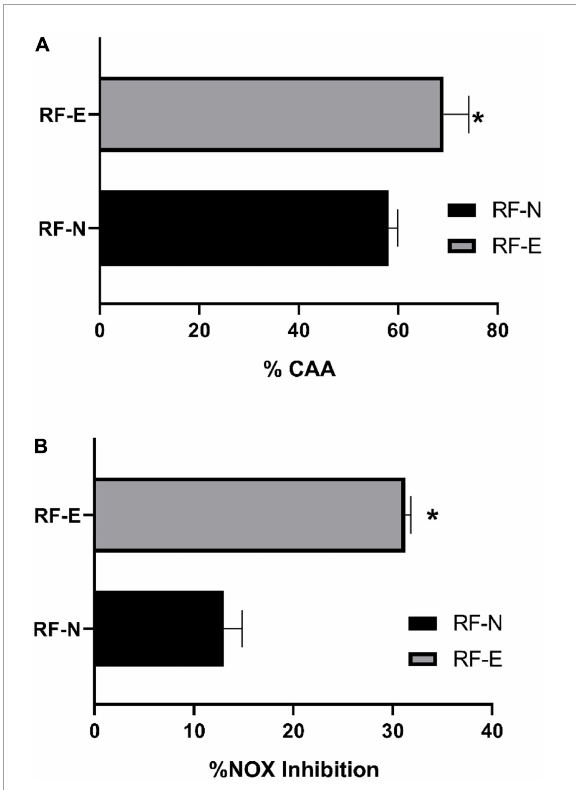
FIGURE7 (A) Cellular antioxidant capacity inhibition (%CAA) by APPH radical. (B) Nitric Oxide (NOX) cell production inhibition (%). Bar indicates standard deviation. *: Means significantly differences between strawberry by-product control (RF-N) and strawberry by-product biofortified (RF-E) samples, according to t -test p <